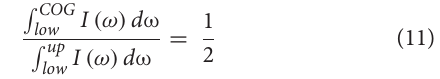
spectrum in Figure 2 ) were integrated to obtain their respective COG using the following